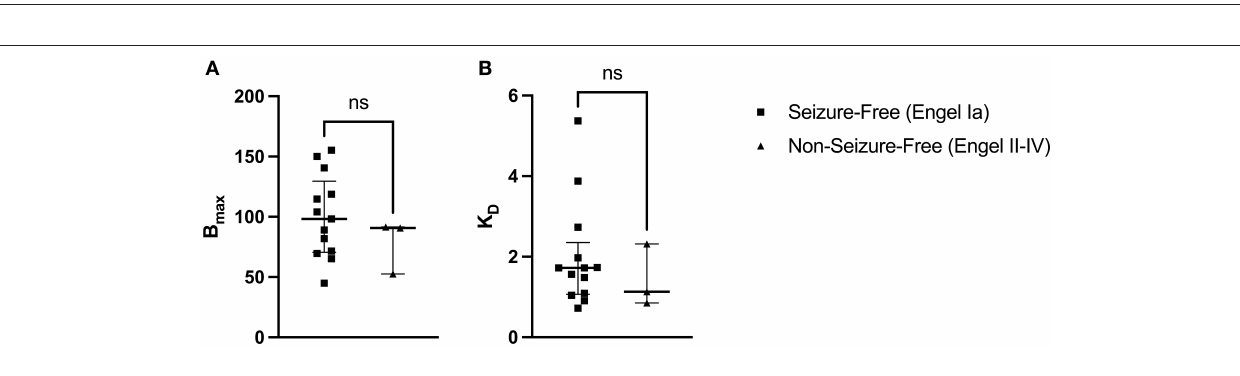
predictor of B max : β (mTLE) = − 72.7288, p = 0.000578, 95% CI [ − 109.1007, −